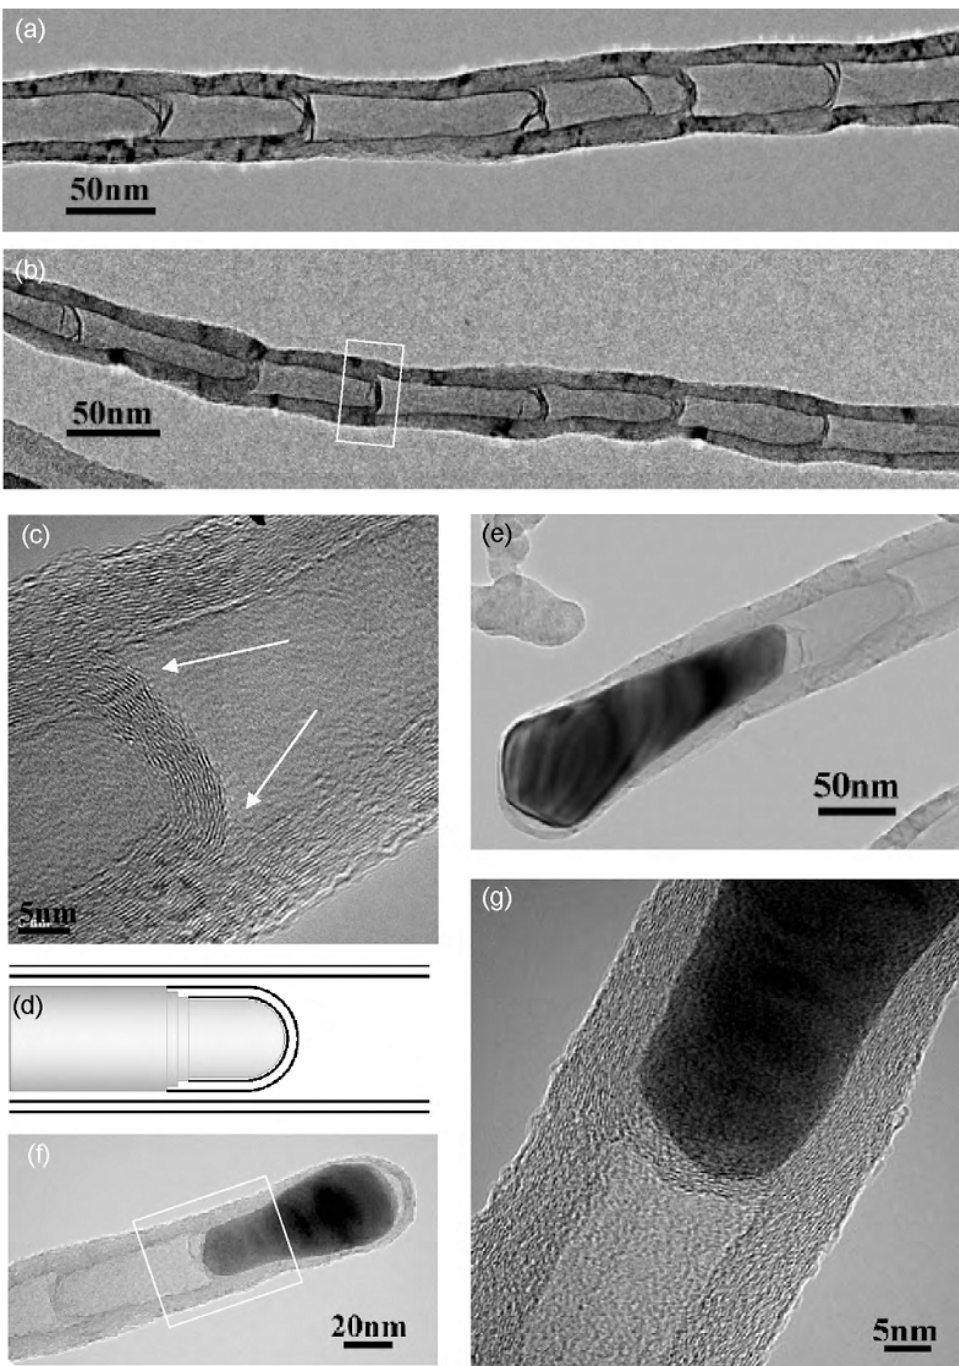
Figure 8. ( a , b ) TEM images of bamboo-like CNTs; ( c ) HRTEM image and ( d ) physical model of the bamboo knot; ( e ) TEM image of a reacting catalyst particle; and ( f , g ) TEM and HRTEM images of a forming bamboo knot (reprinted with permission from Ref. [61], copyright 2010 Elsevier).